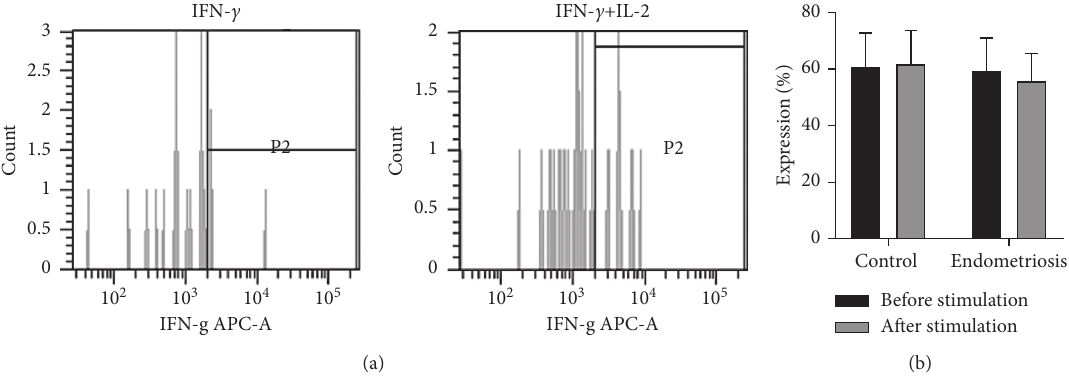
Figure 3: IFN- c production in CD107a+CD56+ cells stimulated with IL-2. (a) Population of IFN- c + cells as determined by flow cytometry analysis. (b) Percentage of IFN- c production in the endometriosis group and control group before and after IL-2 stimulation. The differences before and after IL-2 stimulation were analyzed by paired t